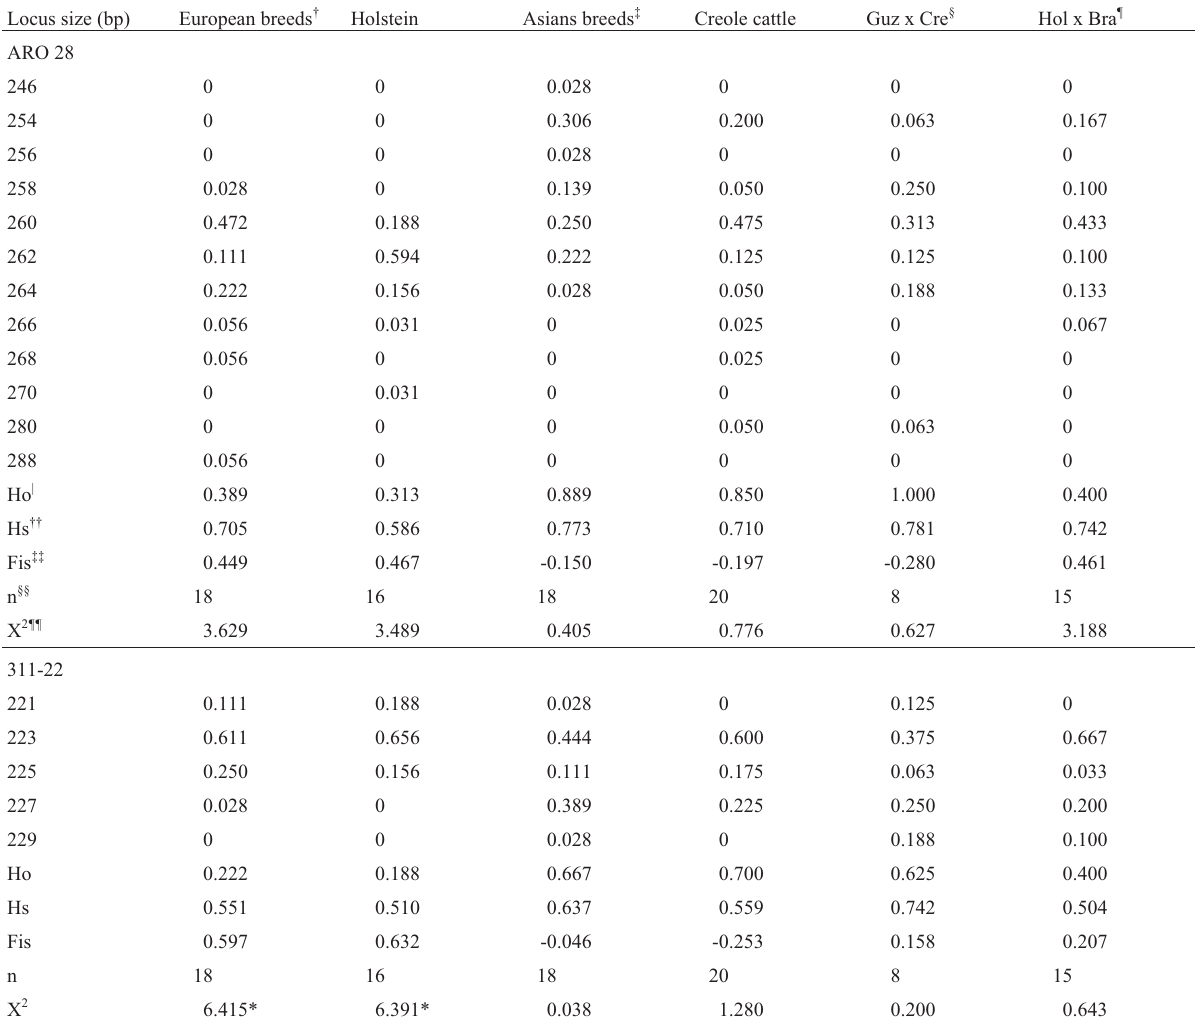
Table 1 - Allele frequencies for ARO28 and 311-22 microsatellites within six bovines populations. Locus size